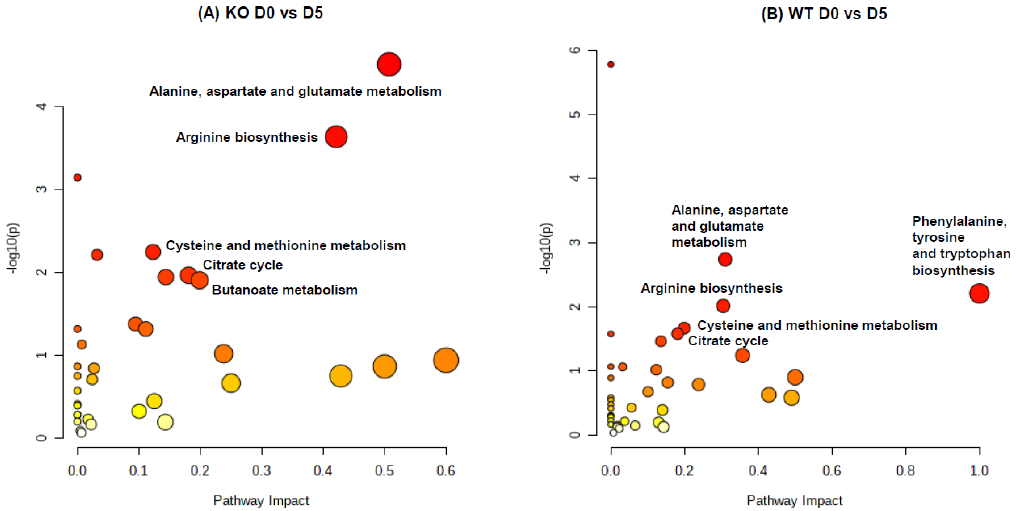
Figure 4. Metabolome view of the pathway impact analysis obtained from significantly changed metabolites in stool from Cef treatments in KO ( A ) and differential metabolites in WT mice ( B ). This analysis was conducted using MetaboAnalyst (www.metaboanalyst.ca, accessed on 1 January 2022). The color and size of each circle is based on p -values (yellow: higher p -values, and red: lower p -values) and pathway impact values (the larger the circle, the higher the impact score) calculated from the topological analysis, respectively. The pathways were considered as significantly impacted if p < 0.05, the impact is 0.1, and the number of metabolite hits in the pathway >